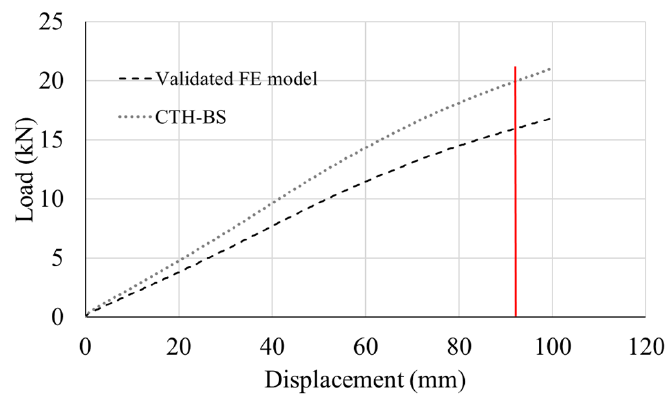
Figure 12. Load–displacement curve comparison for decks with connected bottom flanges of top- hat ribs.